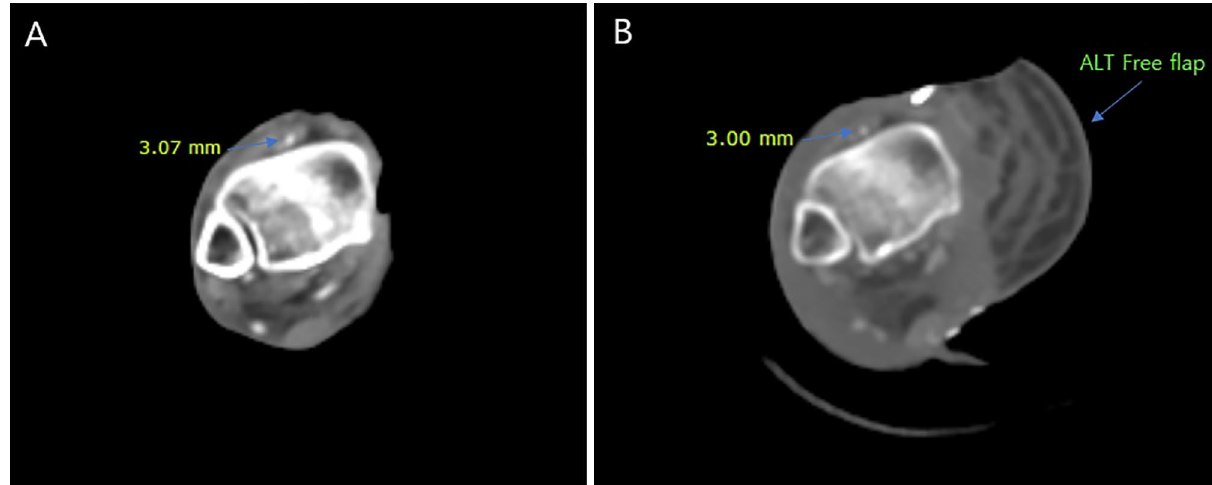
Figure 2. Computed Tomography (CT) angiography finding. Patent flap pedicle was confirmed without the evidence of compression. The diameter of each pedicle was measured. ( A ) Before NPWT system apply,